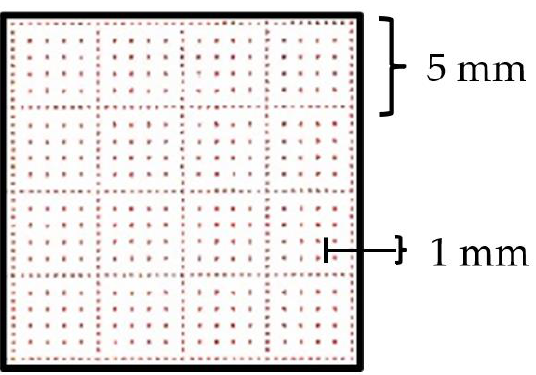
Figure 8. Squares in ECG graph